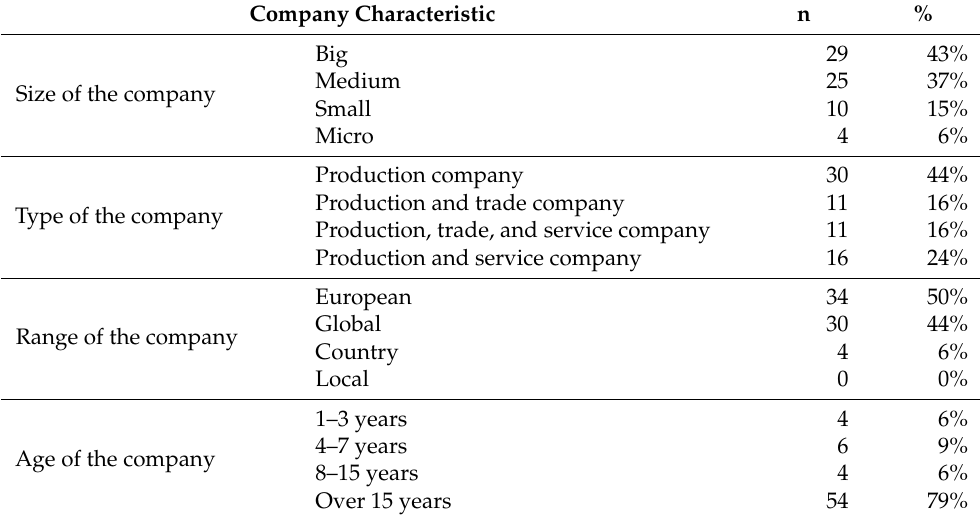
Table 3. Characteristics of the research